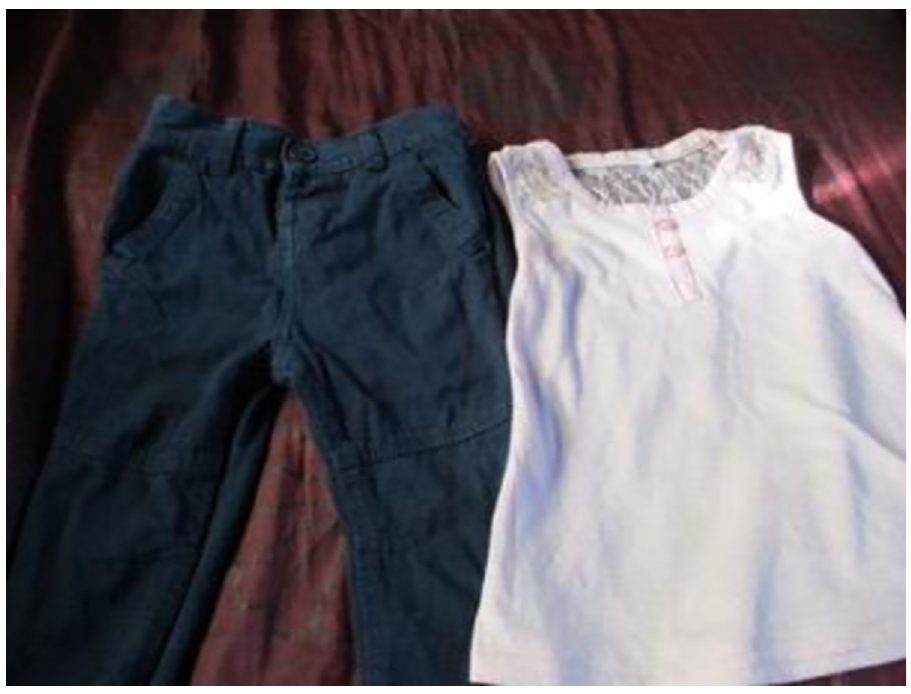
Fig 13. Image from co researcher